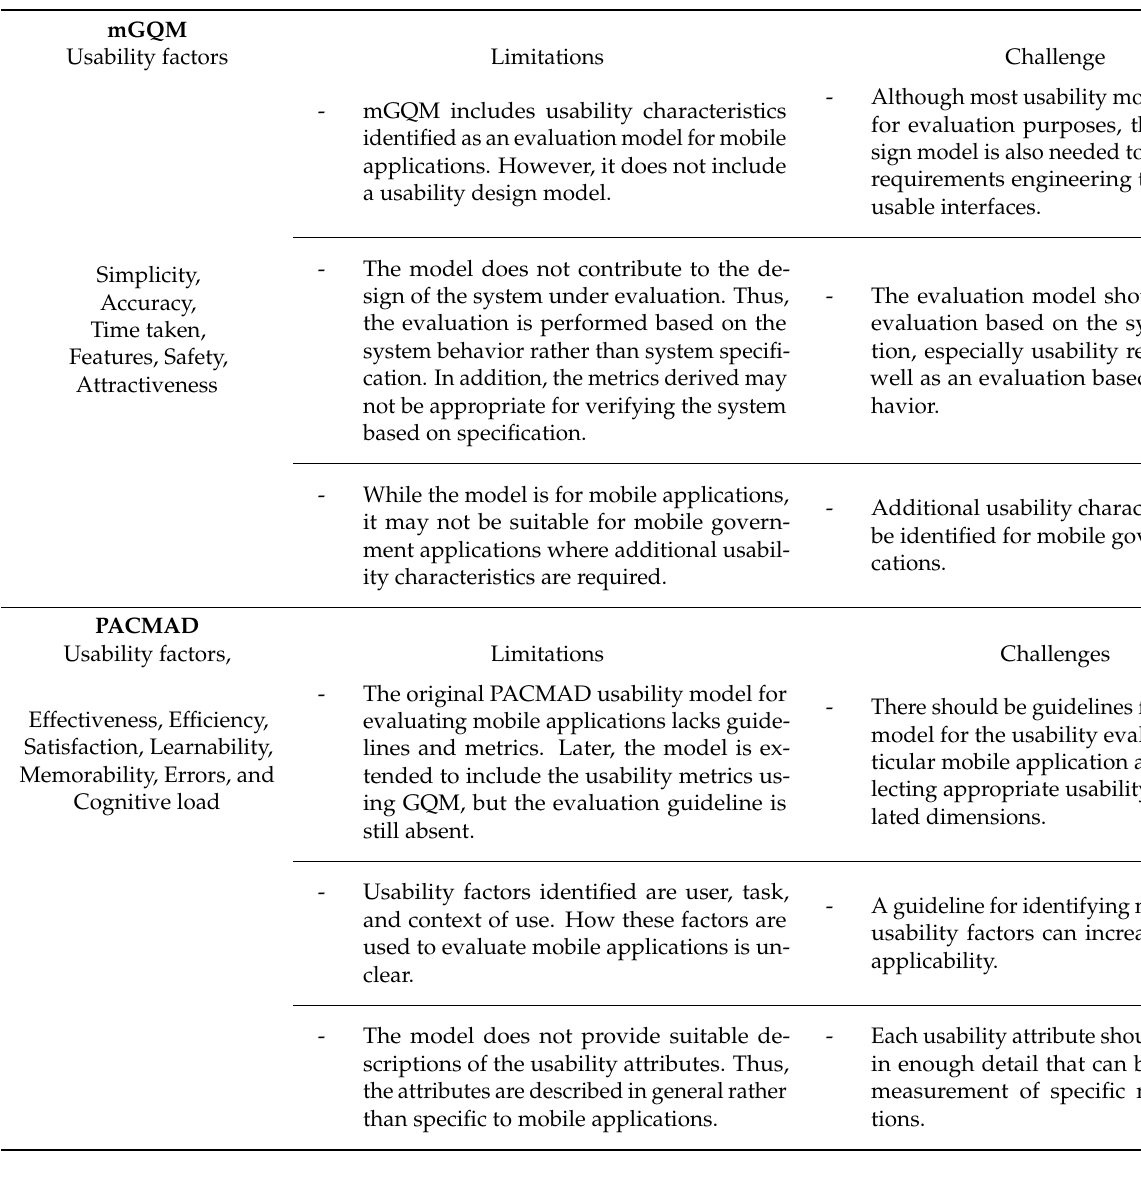
Table 1. Limitations of the existing models and how they can be